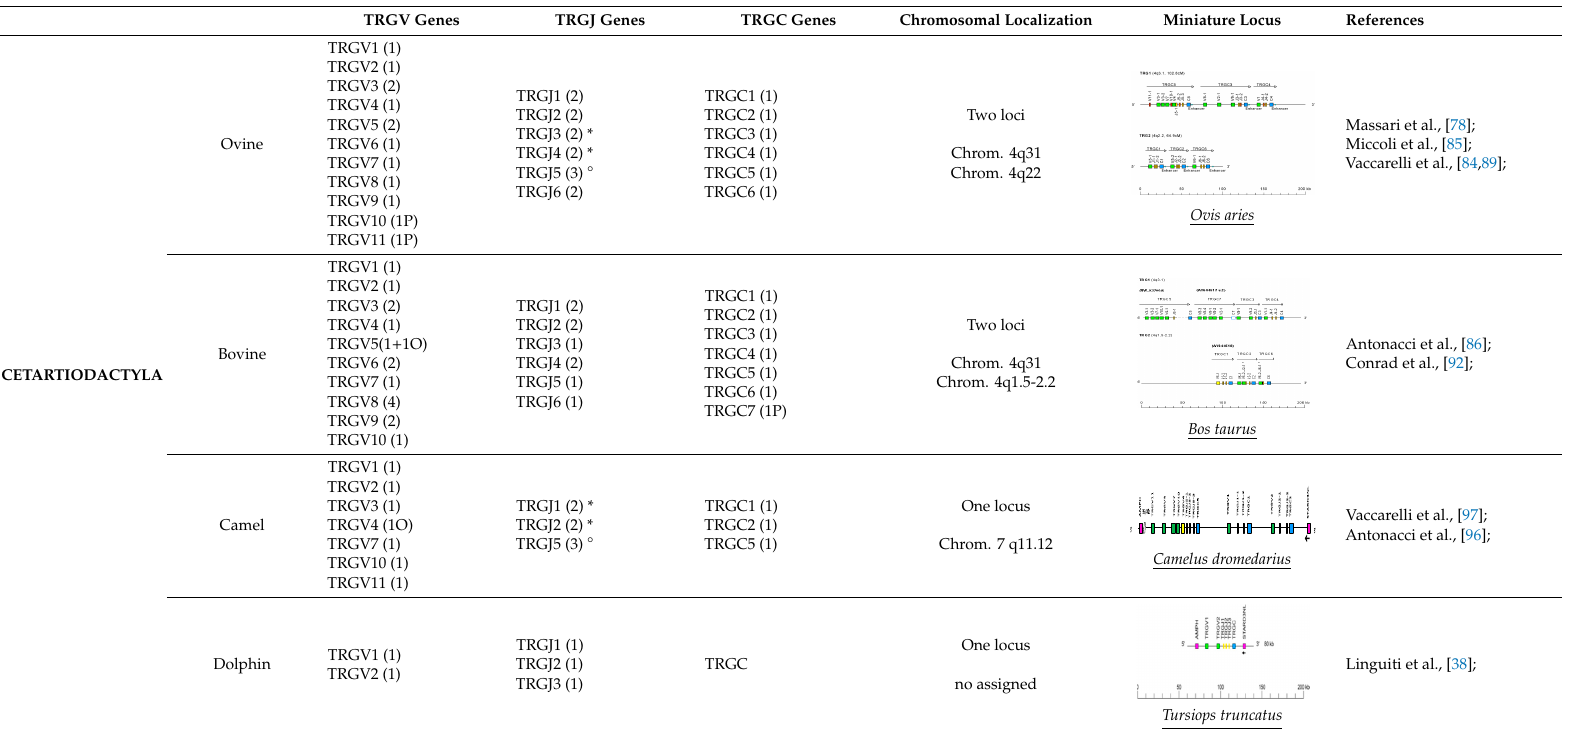
Table 2. Genomic organization and gene content of the TRG locus in Cetartiodactyla and Carnivora.